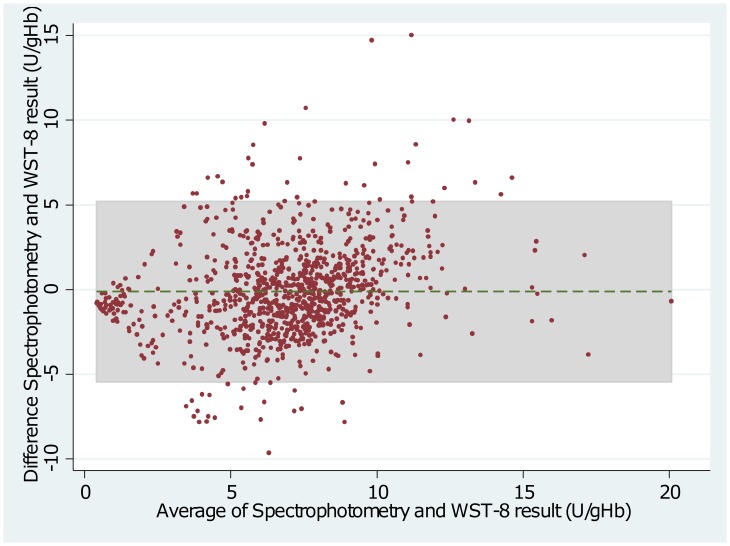
Bland—Altman Plot of Spectrophotometry and WST-8.Dotted line indicates mean difference, grey shaded area indicates 95% limits of agreement.